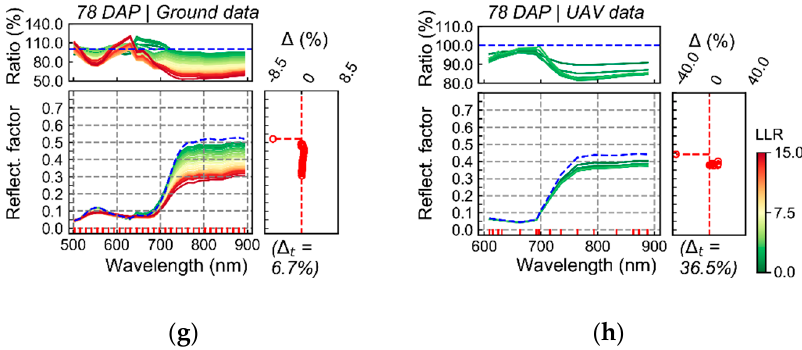
Figure 5. Average reflectance for pixels from T1 (“non-mixed” system) grouped according to log-likelihood ratio (LLR) in discrete intervals, between 0 to 15, in steps of 0.5. LLR, compares pixel-wise probability estimated for T1 (H1) in contrast to T2 (H0; “mixed” system). Ground ( a , c , e , g ) and UAV-based ( b , d , f , h ) data are presented for all acquisition dates. Colors of the average spectral signatures indicate the average LLR value for pixels included in a given interval. Ratio indicates the results for the division of the reflectance (band-wise) corresponding to a given LLR interval by that from the interval with the lowest LLR values (i.e., pixels with LLR below 0.5; indicated by blue dashed line). Delta ( ∆ ) corresponds to the percentage of observations (pixels) within a given LLR interval for T1 subtracted from the percentage of observations in the same LLR interval for T2 (reference group). Delta is plotted in front of the average spectral signatures representing each LLR interval. Delta total ( ∆ t) indicates absolute cumulated delta values.